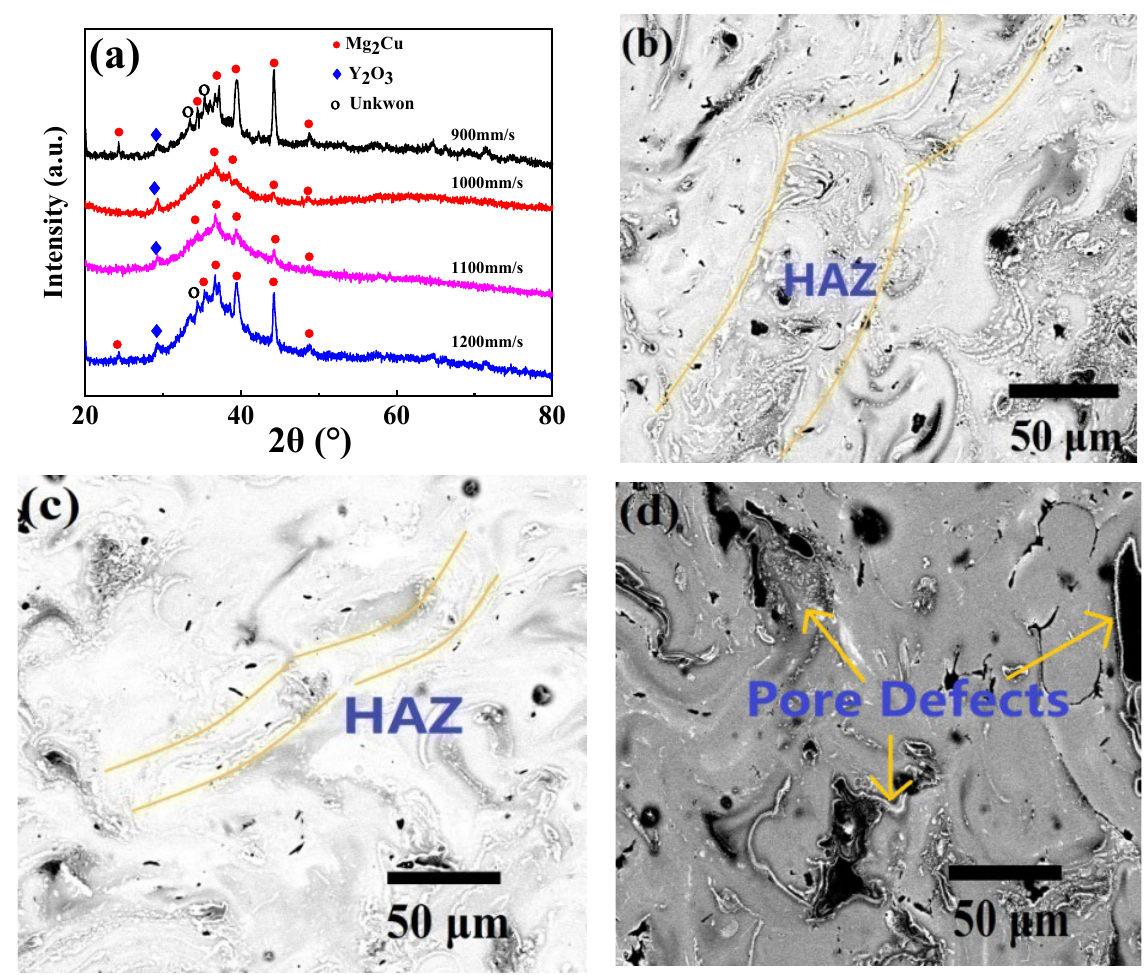
Figure 3. XRD and SEM of 3D-printed Mg-based metallic glasses with laser power of 100 W: ( a ) XRD of the samples with different scanning speed. ( b ) SEM of the cross-section at scanning speed of 900 mm/s. ( c ) SEM of the cross-section at scanning speed of 1000 mm/s. ( d ) SEM of the cross-section at scanning speed of 1200 mm/s.